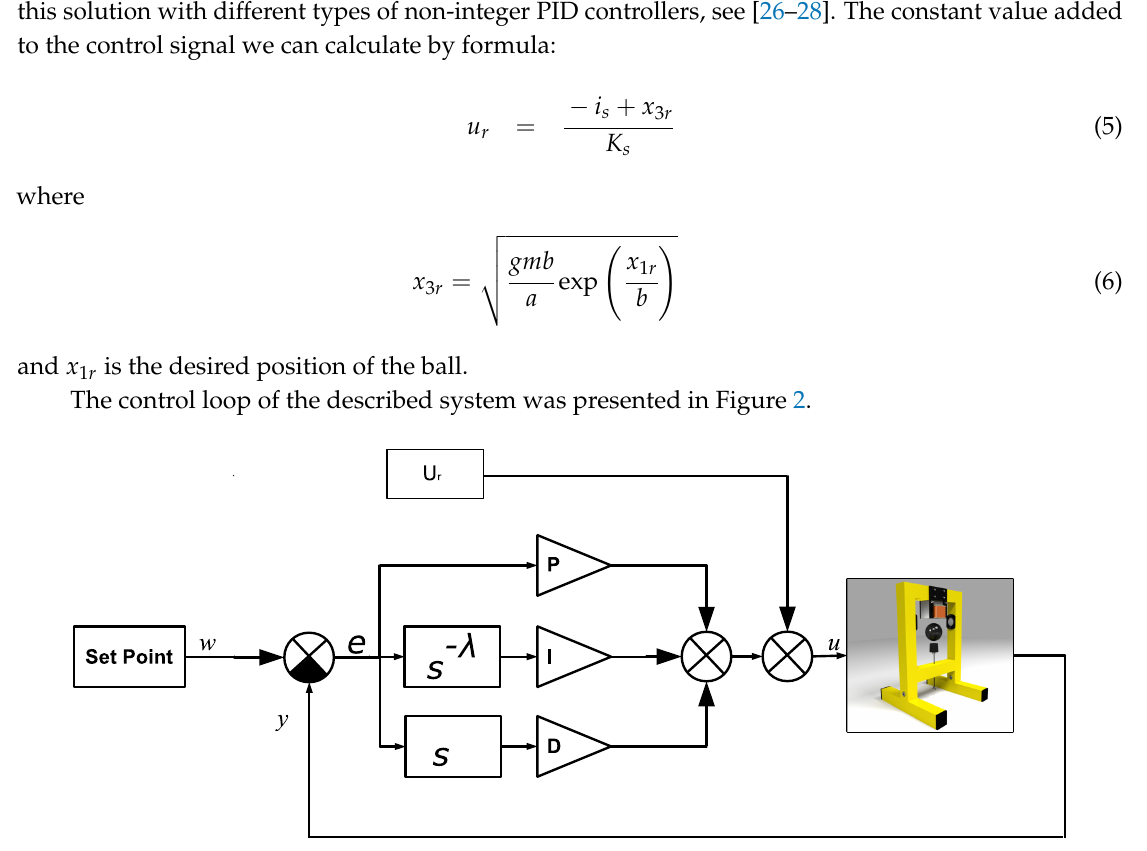
Figure 2. Control loop schema for laboratory magnetic levitation with PI λ D controller. In the diagram, we can see how to connect a regulator of a non-integer order and constant control value to laboratory magnetic levitation